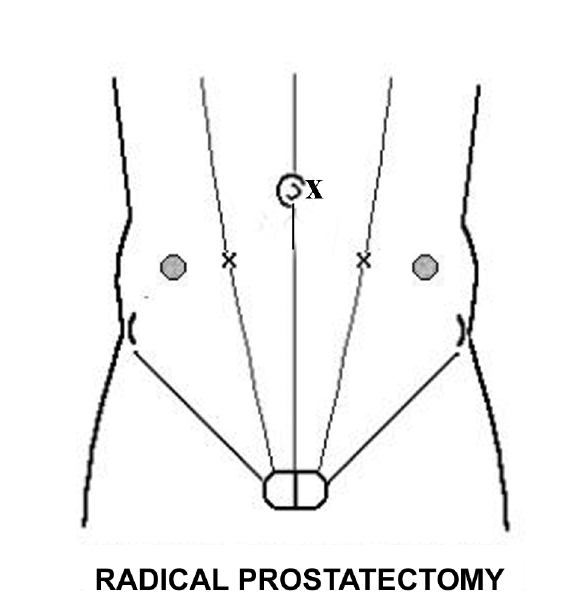
Figure 1 – Display of trocars in arciform shape. The 0-grade optics is placed in the umbilical trocar. Two pararectal 10-mm ports and another 2 5-mm ones in iliac fossa complete the ac- cess. O = 5-mm trocar, X = 10-mm trocar